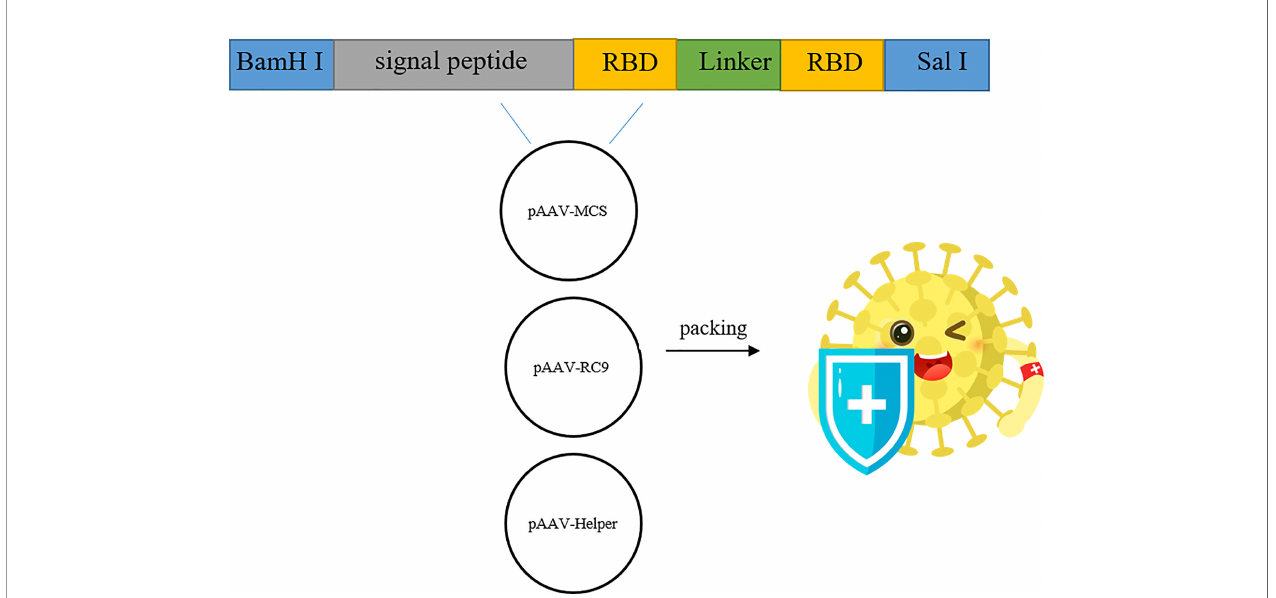
FIGURE 1 | Construction and genome composition of recombinant AAV9-RBD. Four pAAV-RBD plasmids were constructed. Clone 1 contains tPA signal peptide in self-complementary form. Clone 2: contains tPA signal peptide in single-stranded form. Clone 3 contains Glu signal peptide in self-complementary form. Clone 4 contains Glu signal peptide in single-stranded